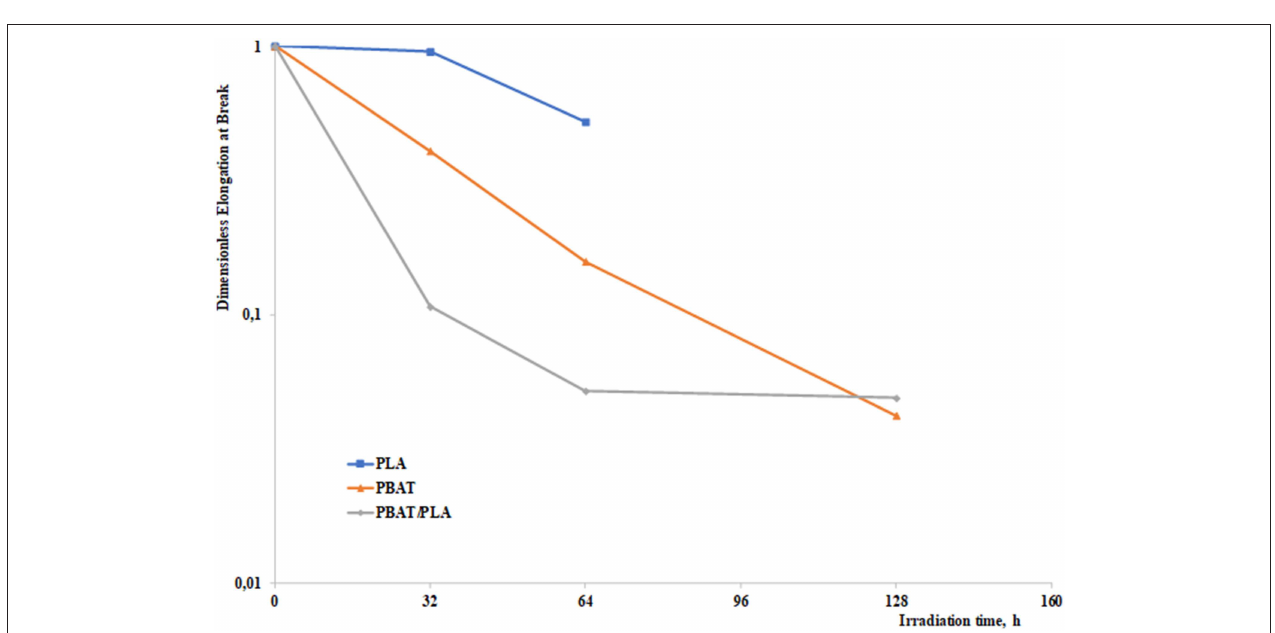
FIGURE 8 | Dimensionless elongation at break as a function of the irradiation time.